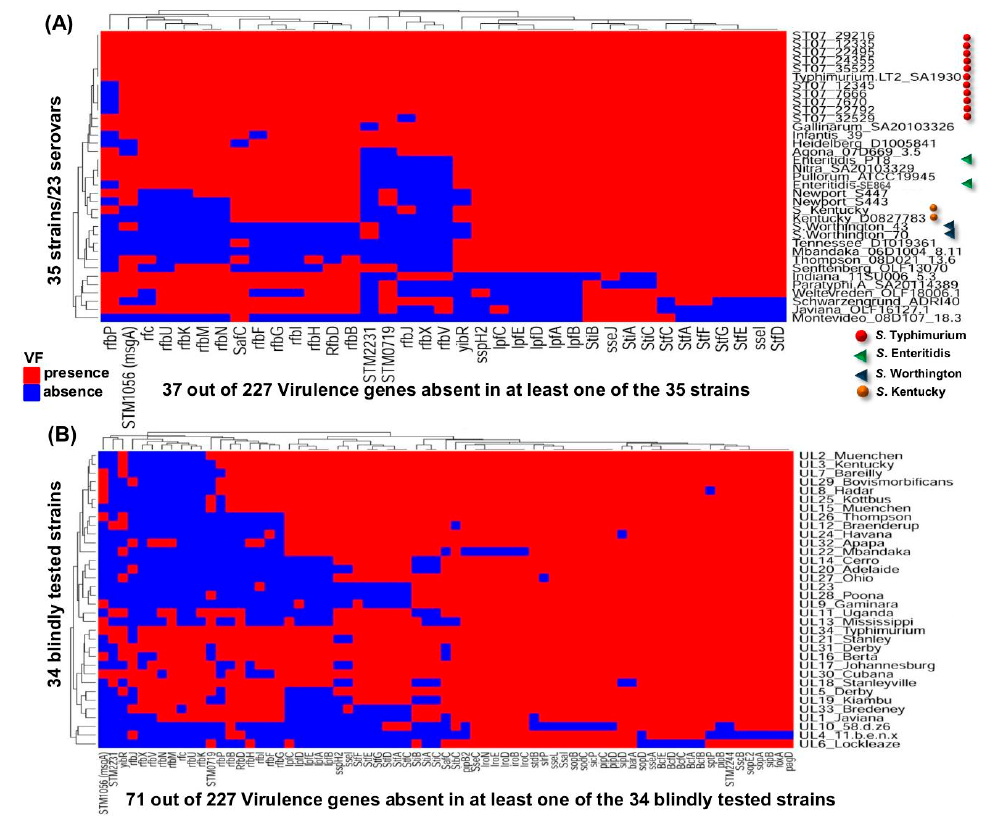
Figure 4. Heatmap illustration showing presence/absence of variable virulence genes (VGs) of Salmonella . ( A ) The 35 OLF strains representing 23 serovars. ( B ) The 34 SalFos strains. The x axis contains the list of variable VGs out of 227 used to design primers for the AmpliSeq Salm_227VG tool. The y axis depicts the Salmonella strains and their identities. Red and blue colors represent presence and absence of a VG, respectively. The following serovars are highlighted because more than one strain was used in this study: Typhimurium • , Enteritidis (cid:78) , Worthington (cid:78) , Kentucky • . The remainder of the 227 VGs which were found in all strains (core VGs) are not shown in this